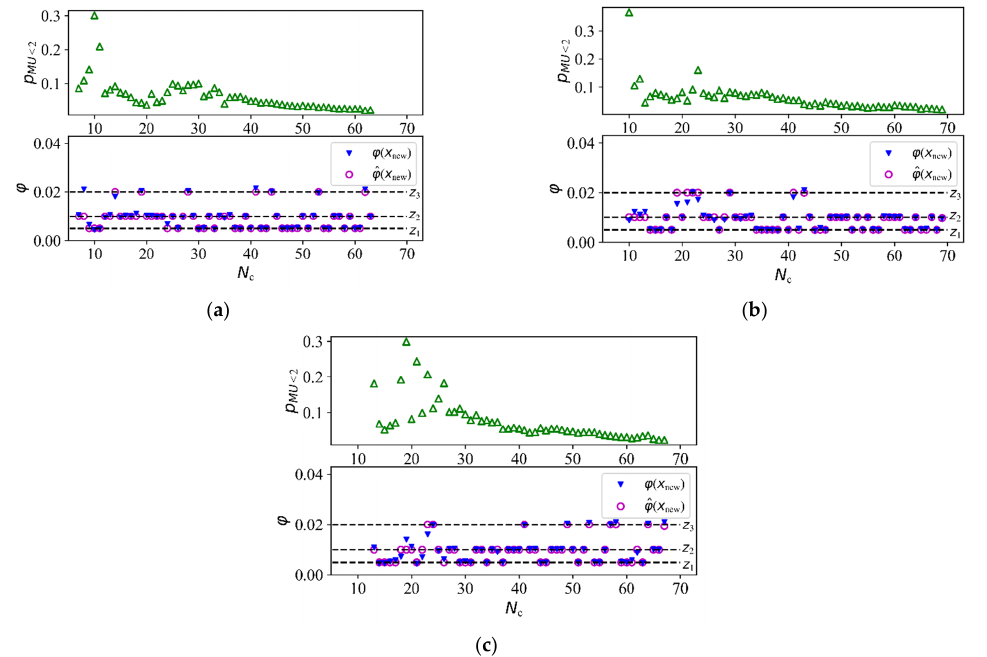
Figure 10. The seismic demand of the added samples of MFVCS. ( a ) N I = 6. ( b ) N I = 9. ( c ) N I = 12.